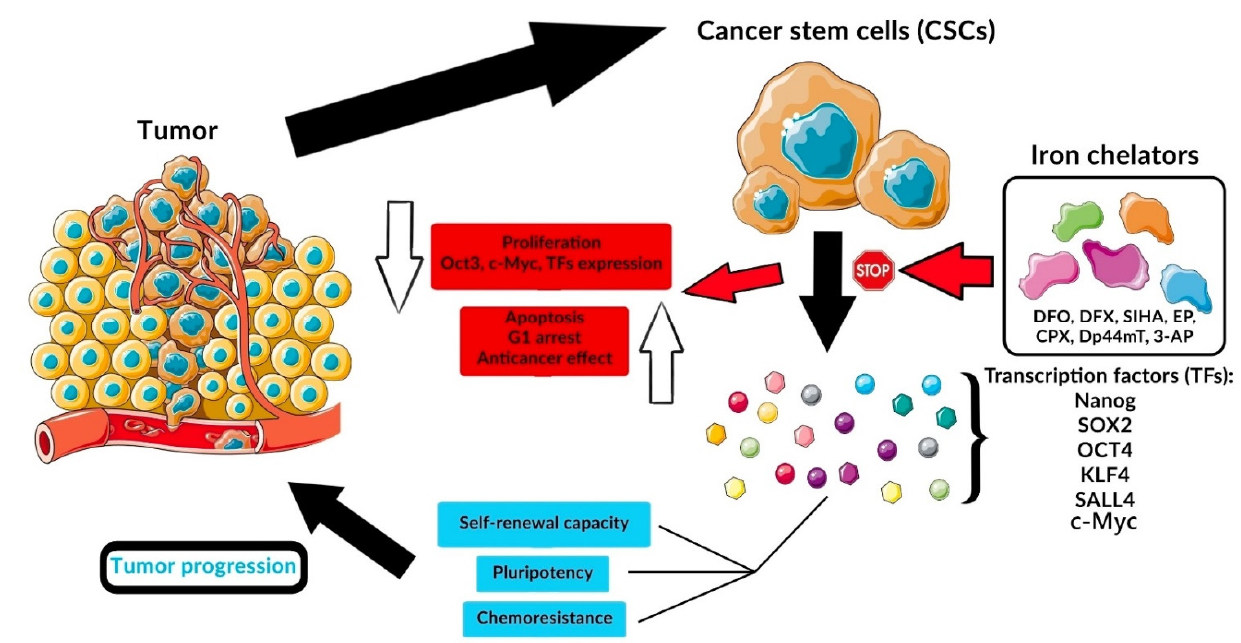
Figure 1. Effect of various iron chelators on CSC and tumor